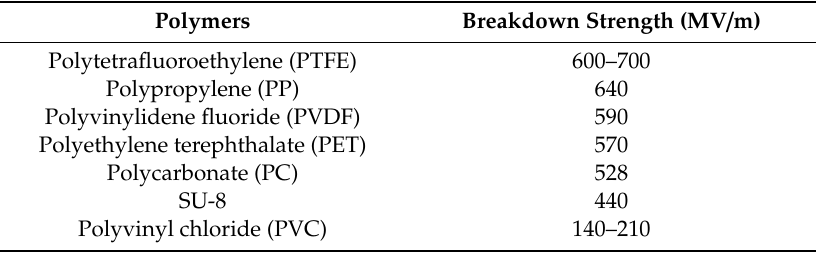
Table 1. Breakdown strength (dielectric strength) of some selected polymers.